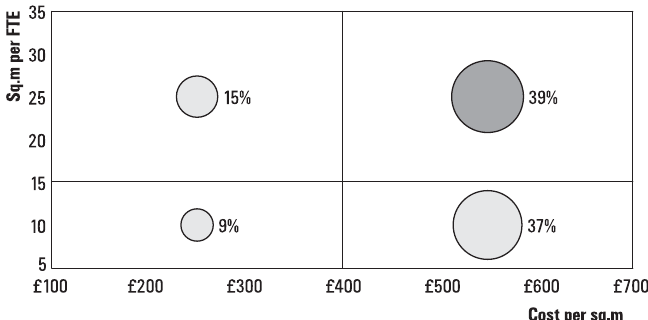
Figure 1. Occupancy cost per area and workspace density in public offi ces by quadrant Source: OGC and IPD